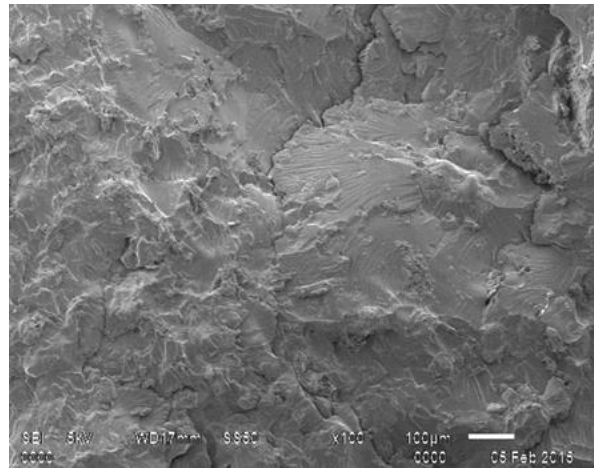
Figure 7: Scanning electron micrograph for (CY-230 + 10 wt%